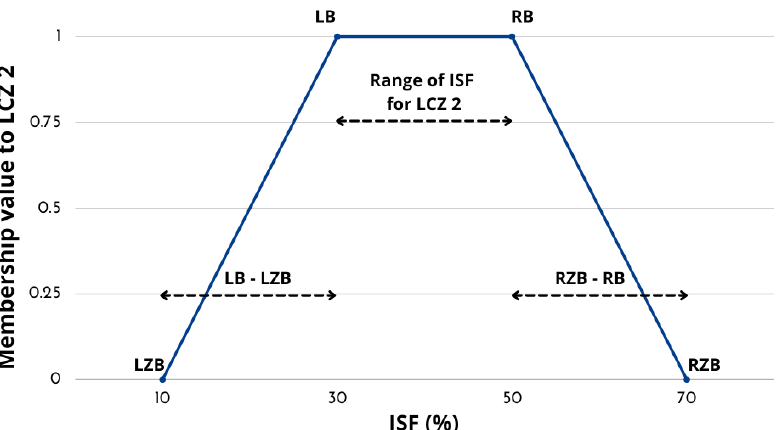
Figure 4. Trapezoidal membership function of fuzzy logic for ISF of LCZ 2 (adapted from Estacio et al.